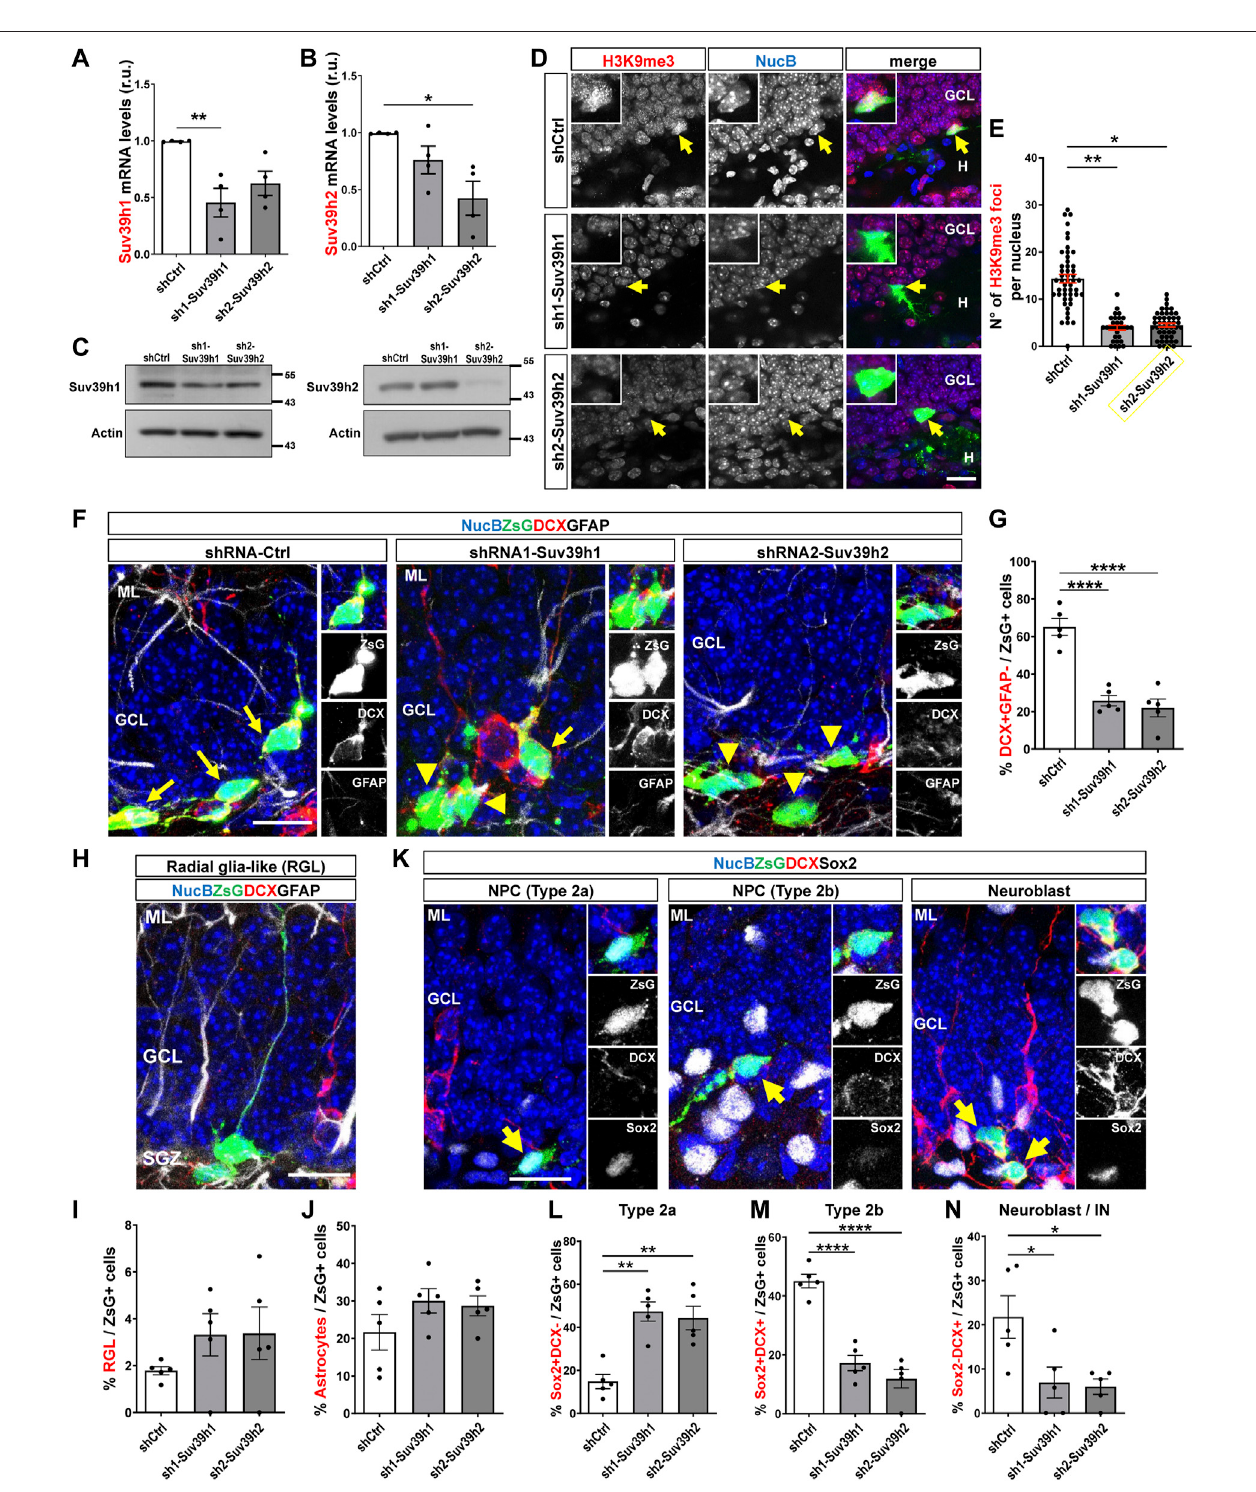
FIGURE7| Suv39h1andSuv39h2knockdownreducesdifferentiationofNPCintheadultmousehippocampus. (A,B) RT-qPCRfromtotalRNAisolatedfromAHP 48 h after being transduced with retroviruses expressing shCtrl, sh1-Suv39h1 or sh2-Suv39h2. mRNA levels of Suv39h1 (A) or Suv39h2 (B) were normalized to the mean value of GAPDH and actin, and expressed relative to AHP transduced with shCtr-expressing retrovirus. Data are presented as mean ± SEM; N (cid:1) 4 independent experiments. (C) Immunoblot analysis of Suv39h1 and Suv39h2 in total protein extracts from AHP transduced for 48 h with retroviruses expressing shCtrl, sh1- Suv39h1 or sh2-Suv39h2. Actin was used as loading control. Numbers on the right indicate molecular weight (kDa). (D) Immunostaining of H3K9me3 (red) and ZsG